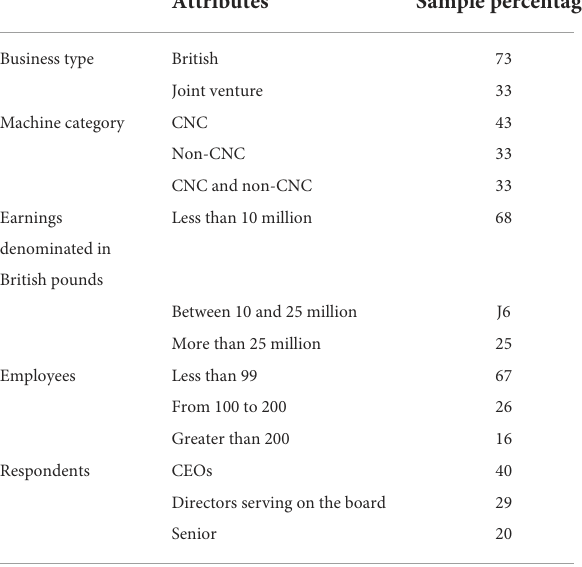
TABLE 1 Sample characteristics.